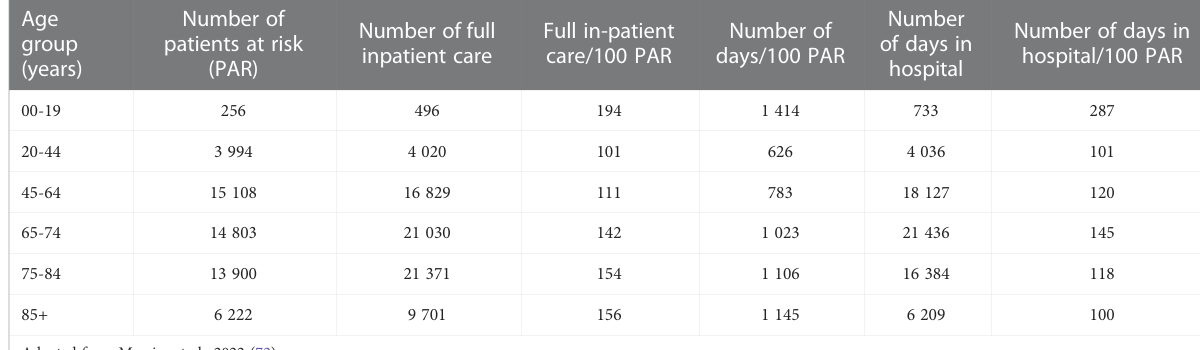
TABLE 1 Hospitalization rates according to age (source REIN registry linked to hospital